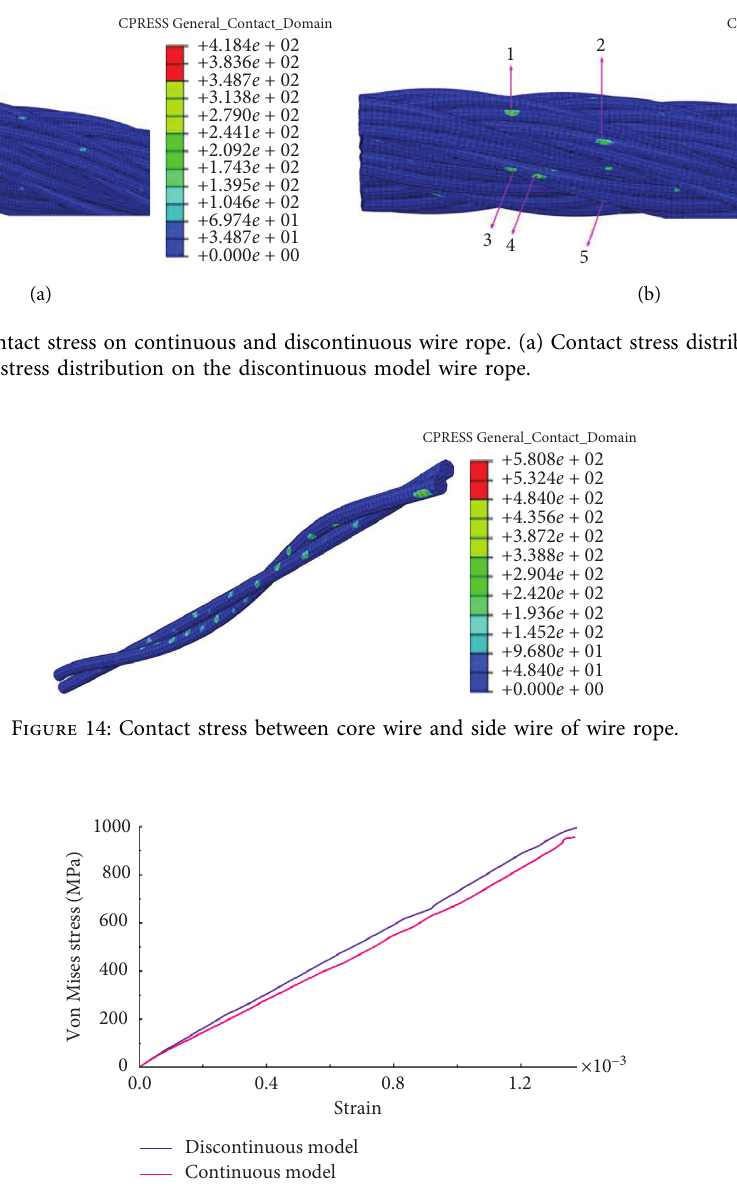
Figure 15: Comparison of continuous and discontinuous Von Mises Stress and